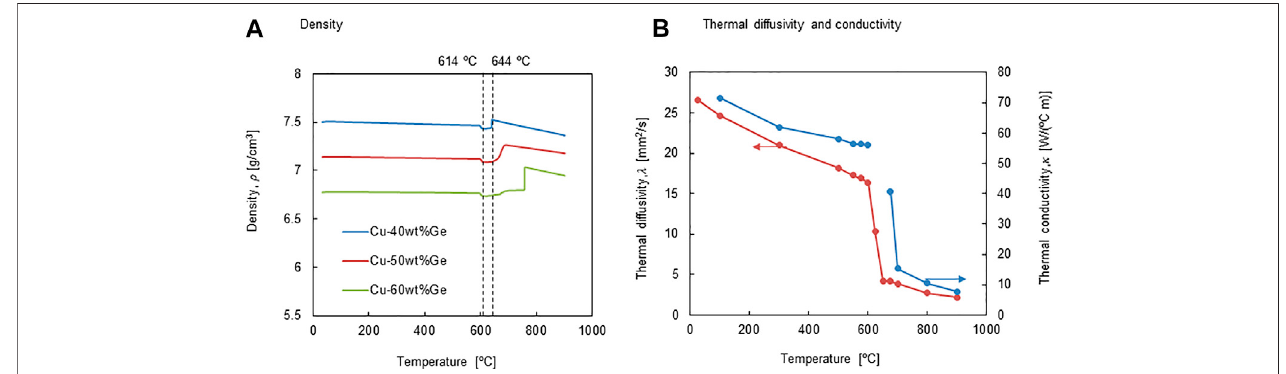
FIGURE 5 | (A) density and (B) thermal diffusivity and conductivity as a function of